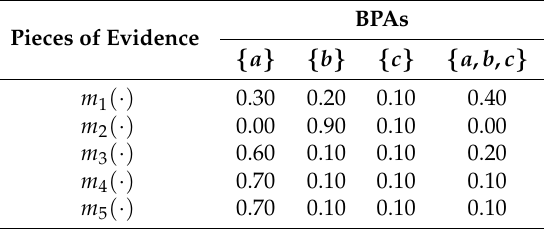
Table 1. The basic probability assignments (BPAs) for the example.